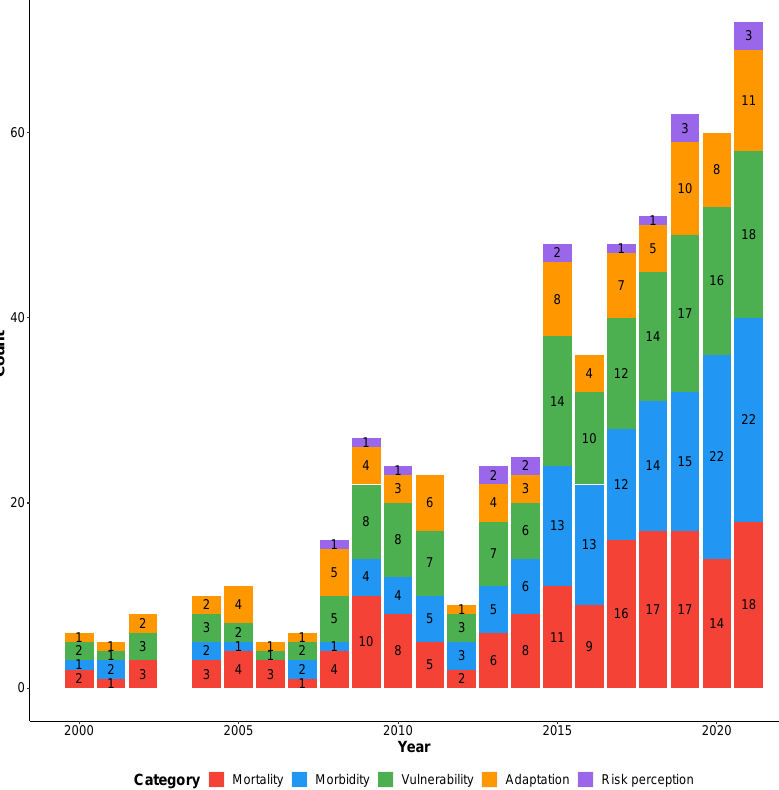
Figure 4. Categories addressed over the